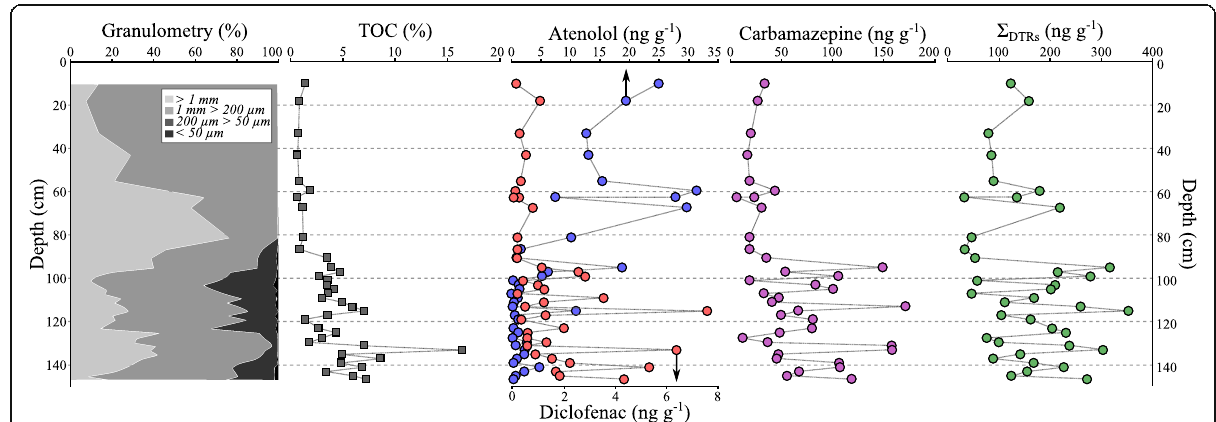
Fig. 3 Vertical distribution of the grain size, the total organic carbon, the concentrations of Atenolol, Diclofenac, Carbamazepine and the sum of all DTRs ( ∑ DTRs ) along core CSA-03/2016 –